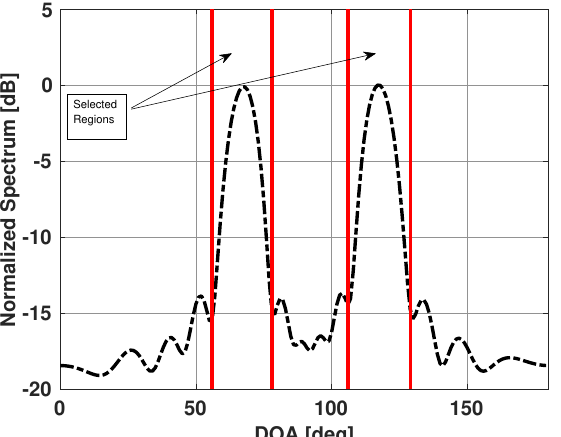
Figure 3. Angular regions selected from the Bartlett spectra for a uniform linear array of 15 elements in the presence of four signals incident at 65 ◦ , 70 ◦ , 115 ◦ , and 120 ◦